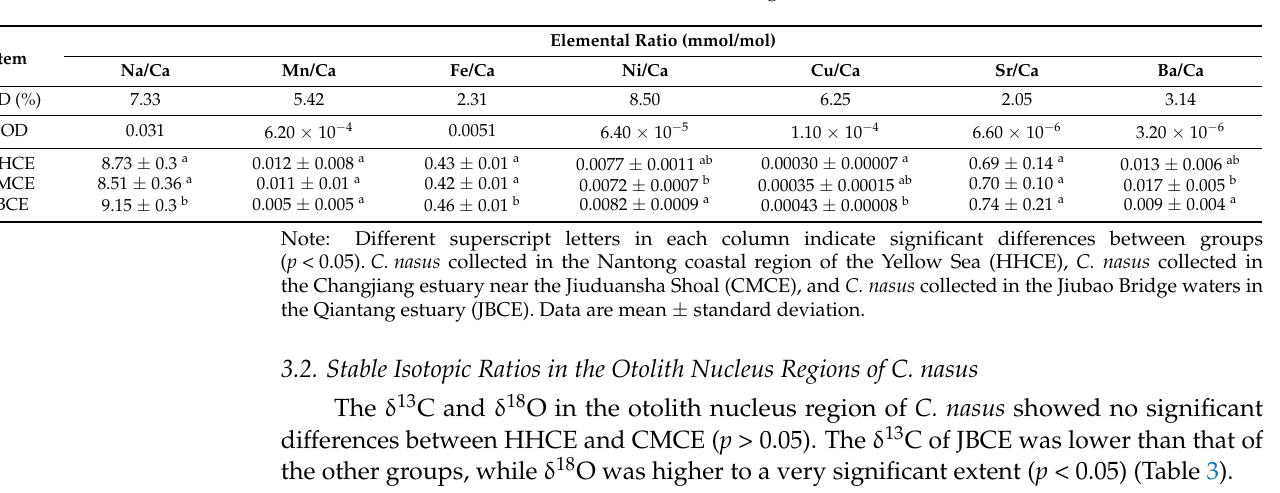
Table 2. Elemental ratios in the otolith nucleus regions of Coilia nasus .